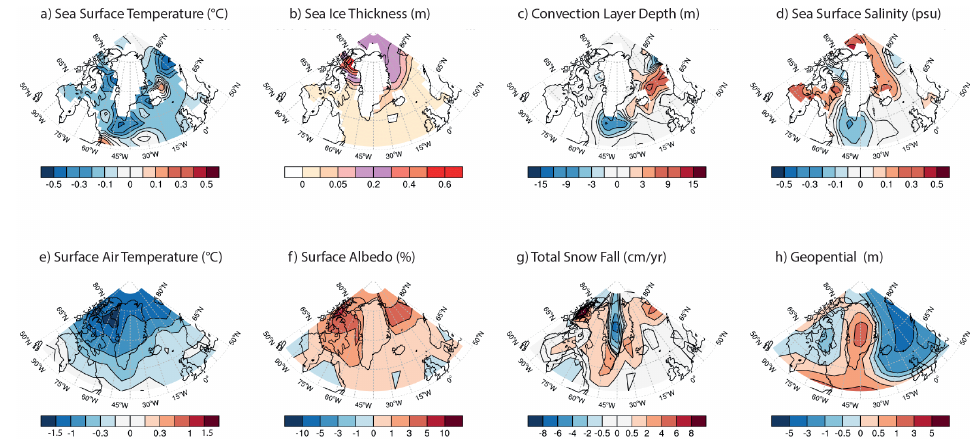
Figure 7. CALV–CTRL differences of 1000-year averages: (a) sea surface temperature, SST ( ◦ C, non-linear colour scheme); (b) sea-ice thickness (m, non-linear colour scheme); (c) convection layer depth, CLD (m); (d) sea surface salinity, SSS (psu); (e) air temperature, TAIR ( ◦ C); (f) surface albedo, ALB (%, non-linear colour scheme); (g) total snowfall, SNOW (cmyr − 1 , non-linear colour scheme); (h) geopotential (m, non-linear colour